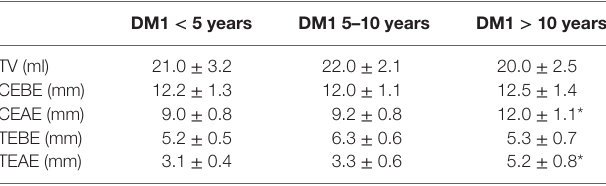
Table 3 | Didymo-epididymal parameters in patients with type 1 diabetes mellitus (DM1) according to the duration of the disease.